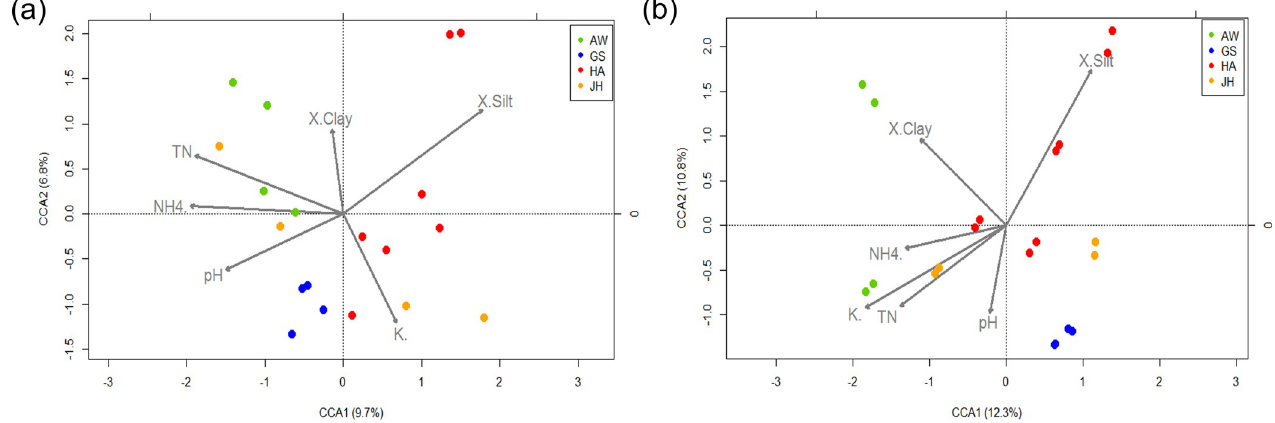
Fig 3. Canonical correspondence analysis for 16S rRNA gene sequence (a) and GeoChip functional gene data (b).